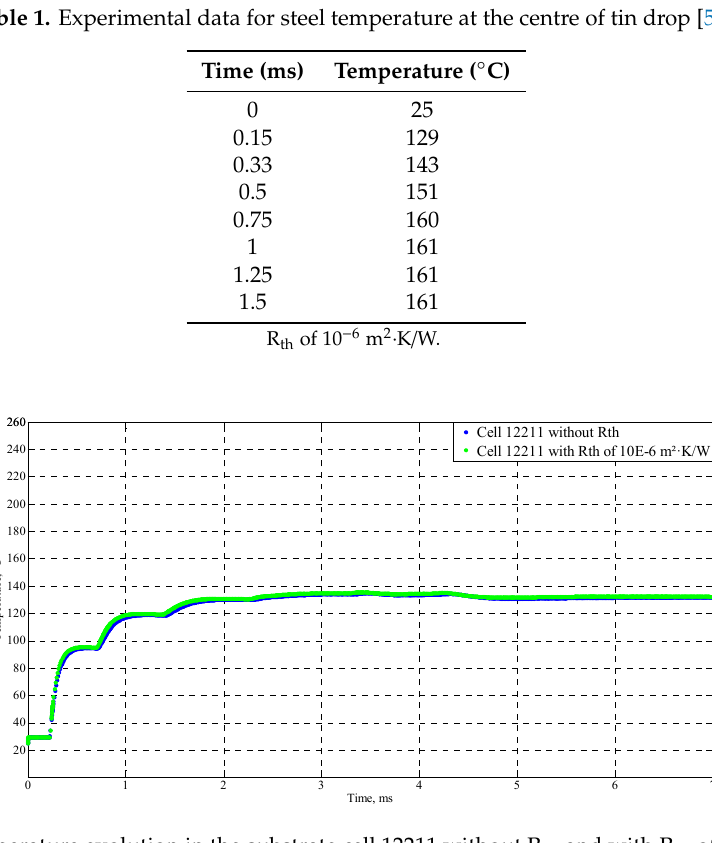
Figure 6. Temperature evolution in the substrate cell 12211 without R th and with R th of 10 − 6 m 2 ·K/W.